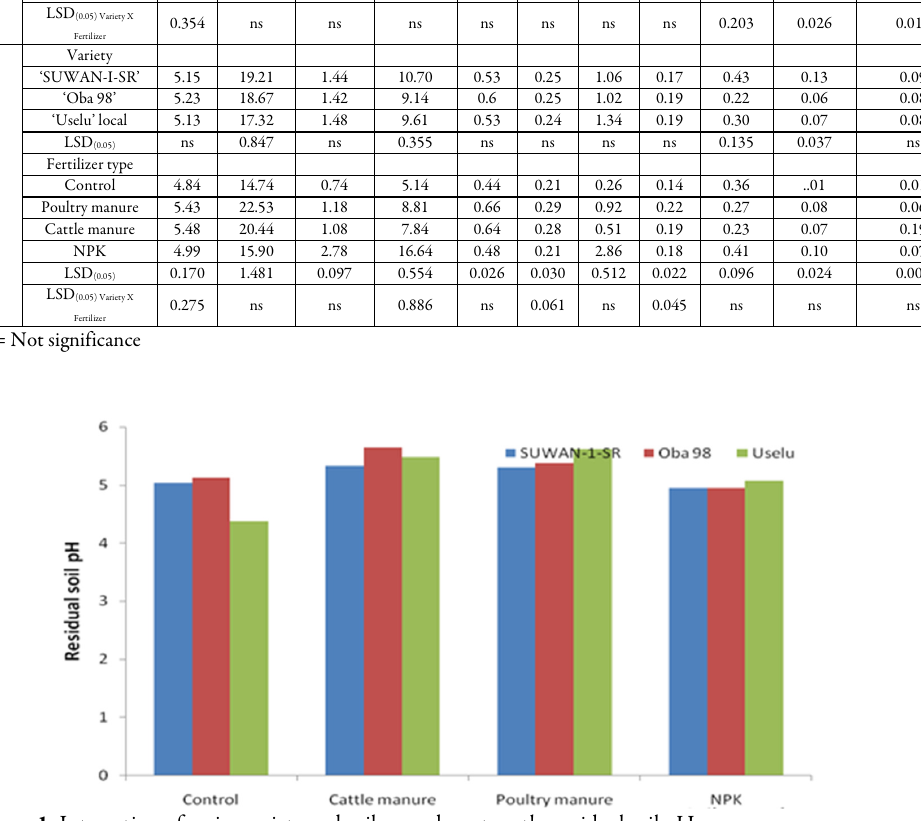
Figure 1. Interaction of maize variety and soil amendment on the residual soil pH